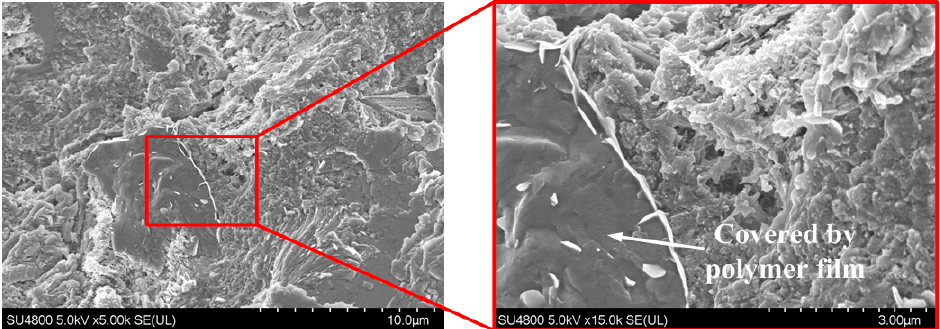
Figure 11. SEM images of the hardened SPC at 28 days.